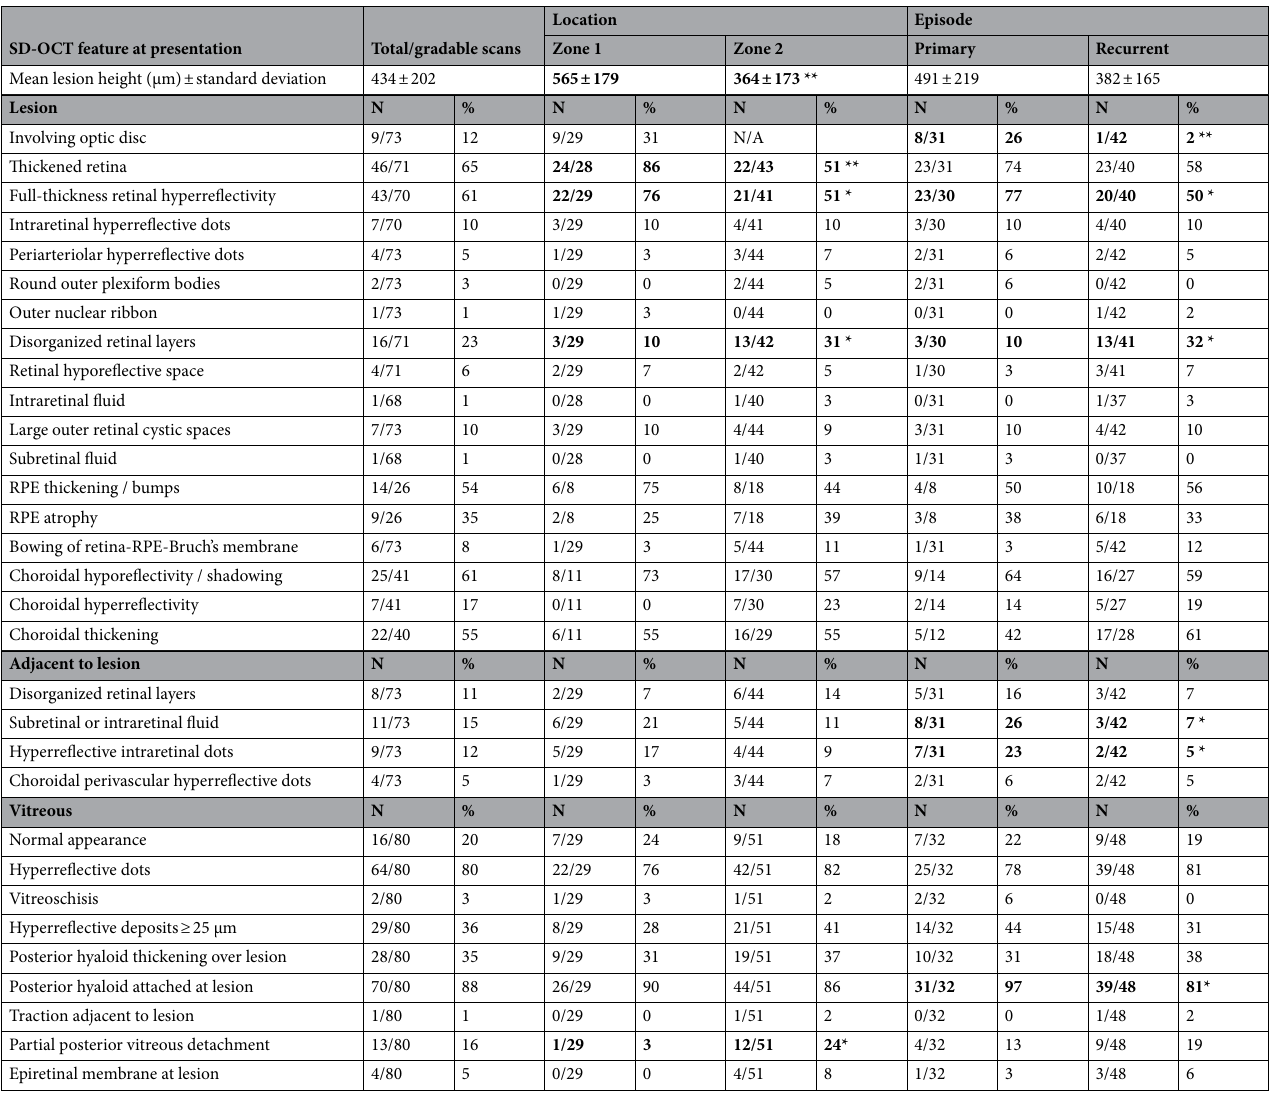
Table 2. Posterior segment features on SD-OCT in active TRC at presentation for 90 eyes of 90 patients. Comparisons were made between TRC lesions located in zones 1 and 2, and primary vs. recurrent